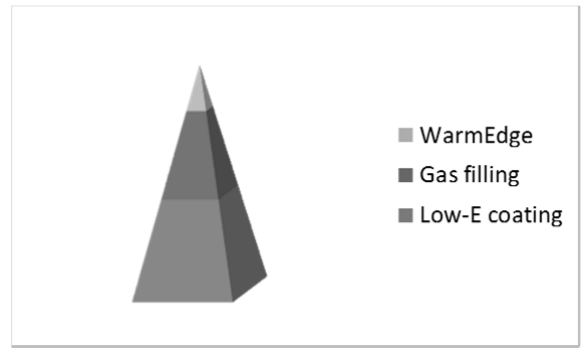
Fig. 24 Contribution to the U-value of double or triple glazing